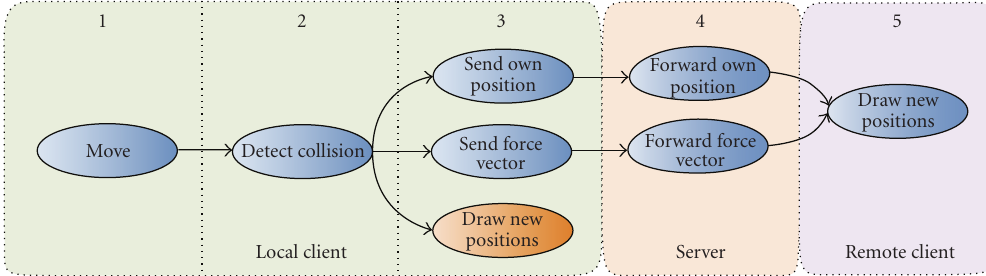
Figure 11: Client-side collision